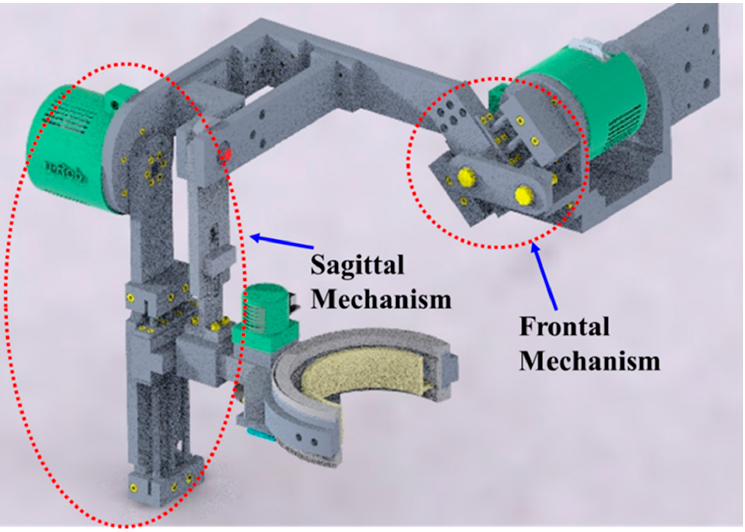
Figure 2. Ergonomic shoulder motion support part of the proposed exoskeleton robot.